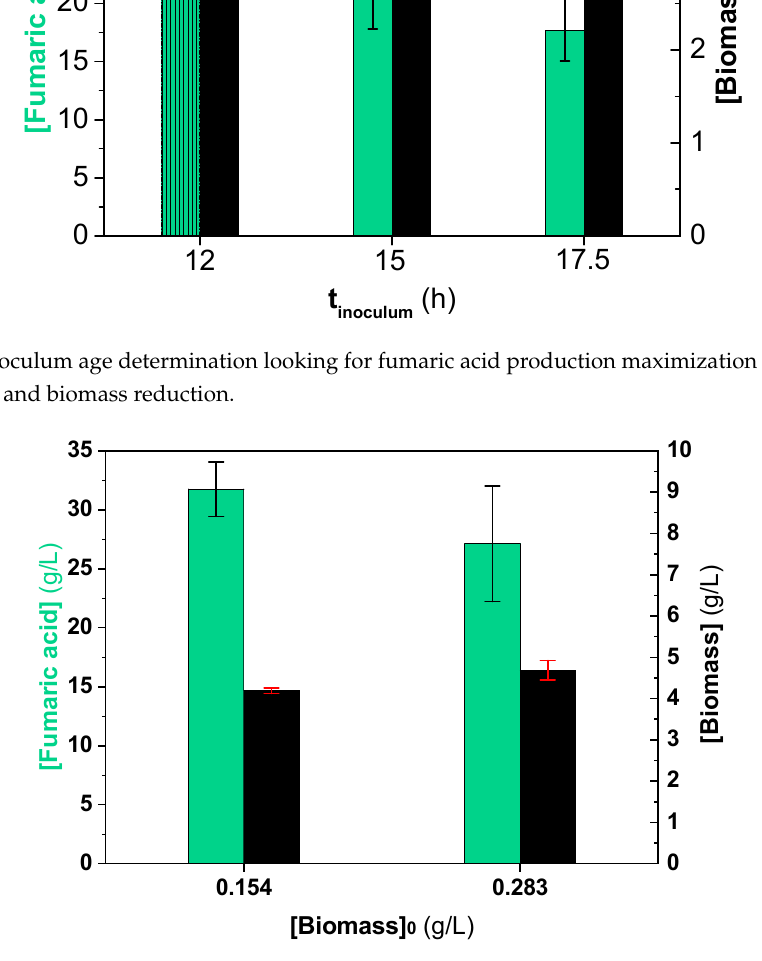
Figure 7. Results of fumaric acid (green) and biomass (black) concentrations using different initial biomass concentration during inoculation.